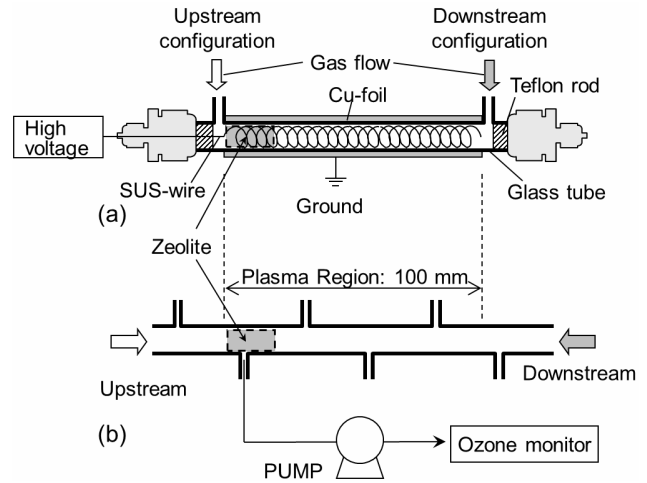
Figure 9. Configurations of ( a ) the zeolite hybrid reactor and ( b ) the reactor for monitoring the ozone distribution in the plasma region.